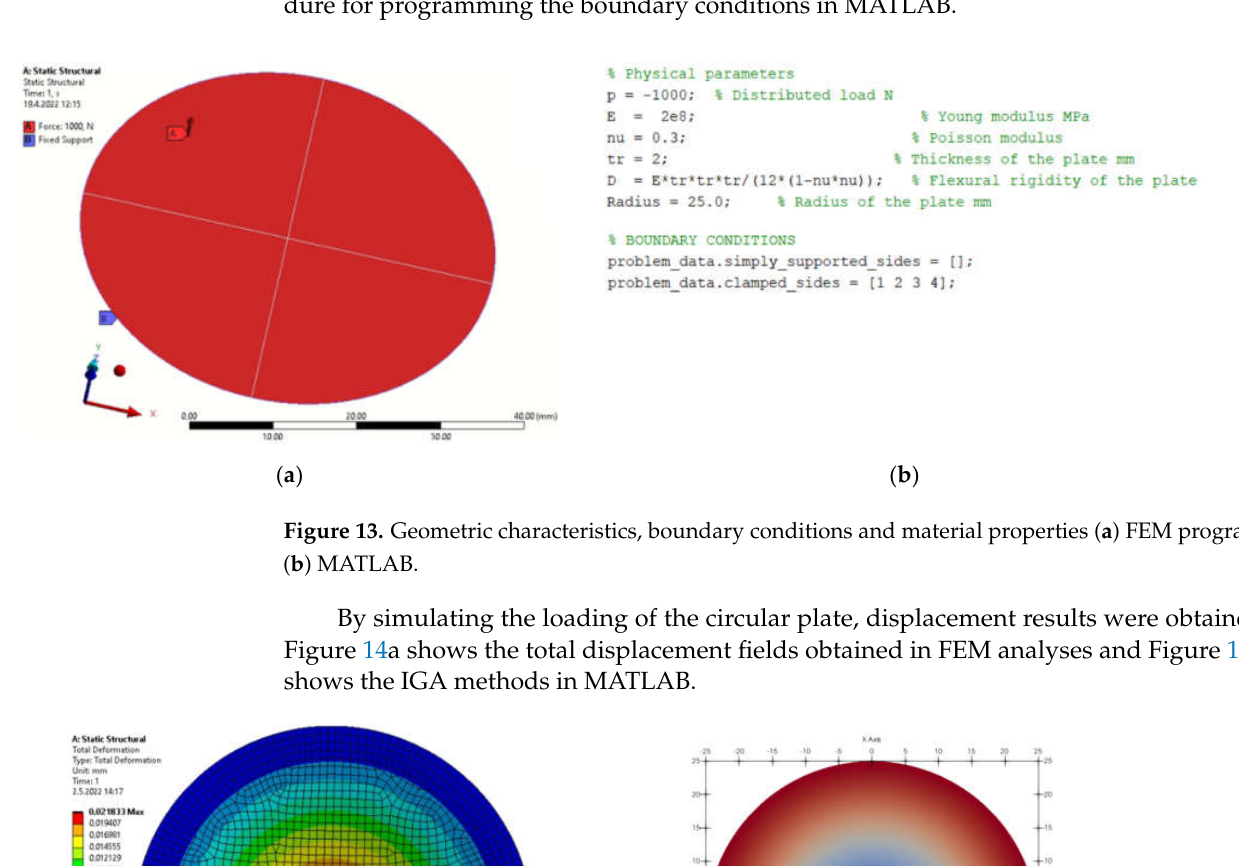
Table 4. Computed displacements of the points for the different solution methods.